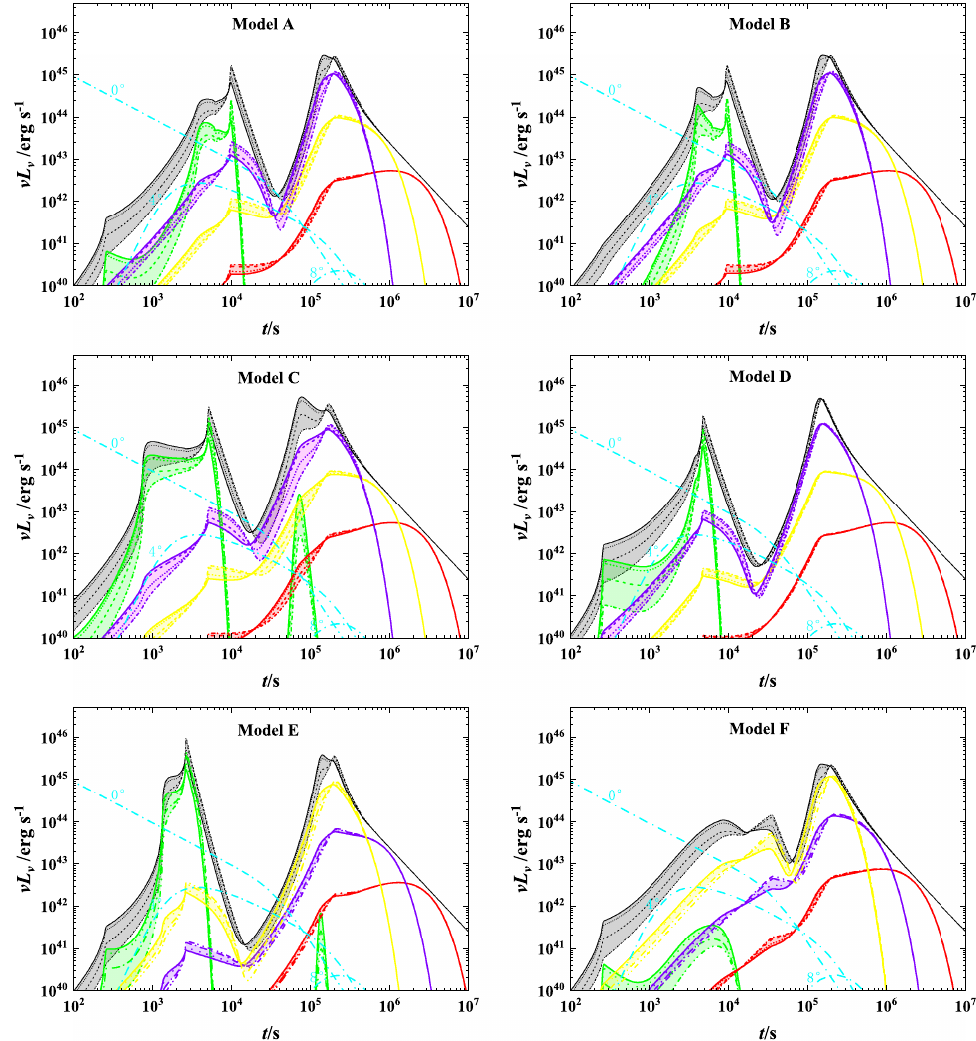
Figure 3. Multi-band light curves of the magnetar-driven SBO (i.e., the first bump at around 10 3–4 s) and mergernova (i.e., the second bump at around 10 5–6 s) emission from an anisotropic merger ejecta for parameters listed in Table 1, including 0.1 keV (green), 6 keV (purple), 2 eV (yellow), 0.5 eV (red) and the bolometric ones (black). For a comparison, the GRB X-ray (0.1KeV) afterglow is also presented by the cyan dotted–dashed lines for three viewing angles of 0 ◦ , 4 ◦ and 8 ◦ , which are yielded from the afterglowpy [87] for a top-hat jet model with a half-opening angle of 3 ◦ , where the typical parameter values as inferred from the GRB 170817A observations are taken as E iso = 10 51 erg, n = 10 − 3 cm − 3 , p = 2.3, (cid:101) e = 0.1, and (cid:101) B = 10 − 4 . Due to the limb-darkening effect, the SBO emission can slightly vary with the observational directions, as labeled by the solid ( Θ = 0 ◦ ), dotted (30 ◦ ), dashed (60 ◦ ), and dashed–dotted (90 ◦ )